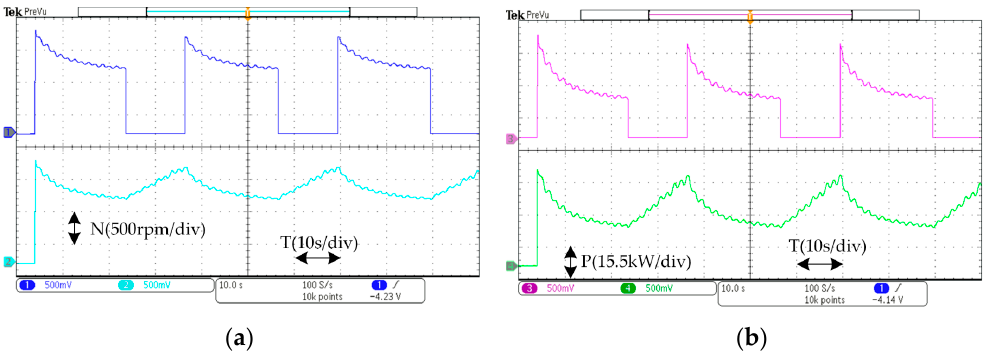
Figure 24. Speed and power curves of G1 and G2 under regular waves. ( a ) Speed curve of G1 and G2; ( b ) power curve of G1 and G2.